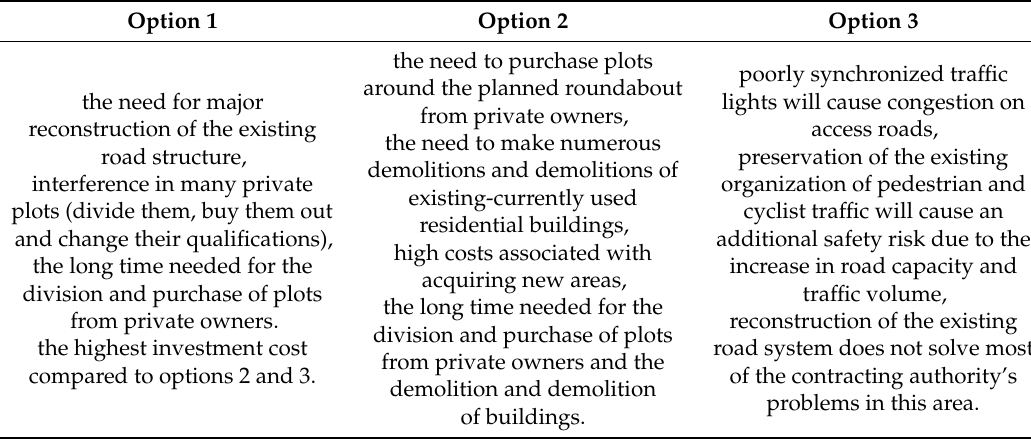
Table 4. Disadvantages of Options 1, 2,